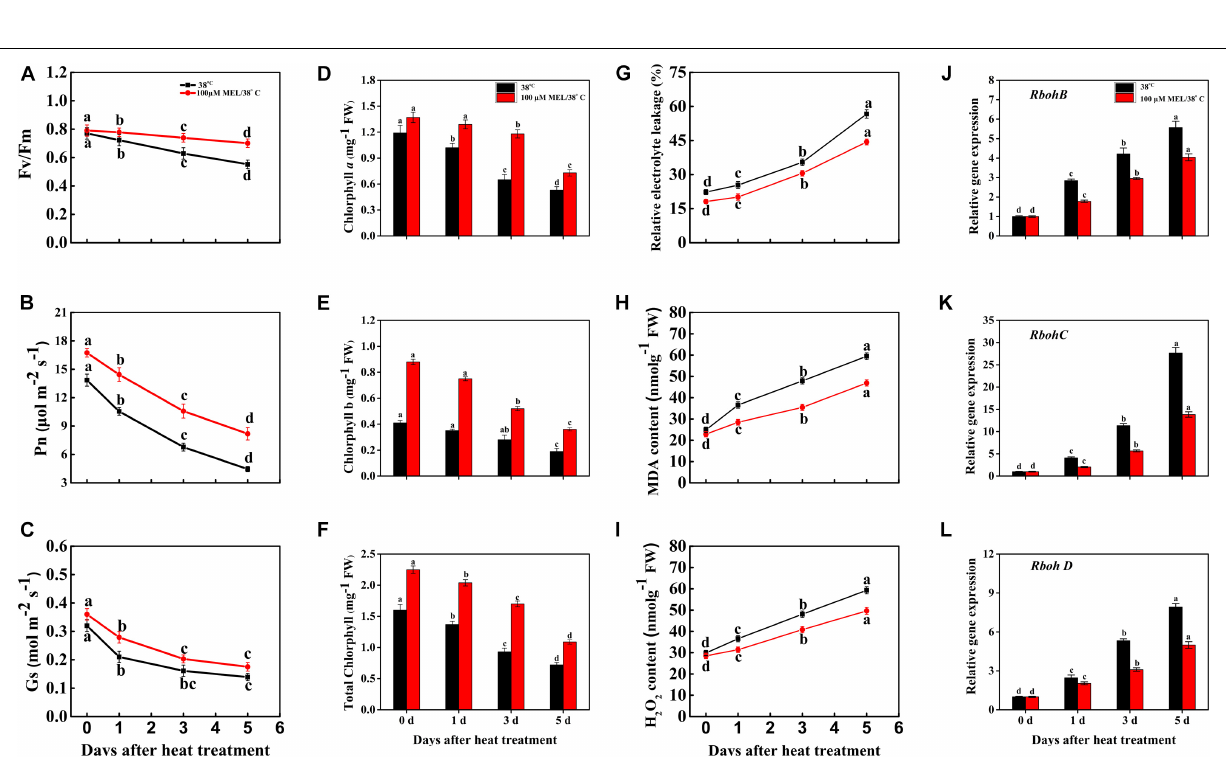
Frontiers in Plant Science |